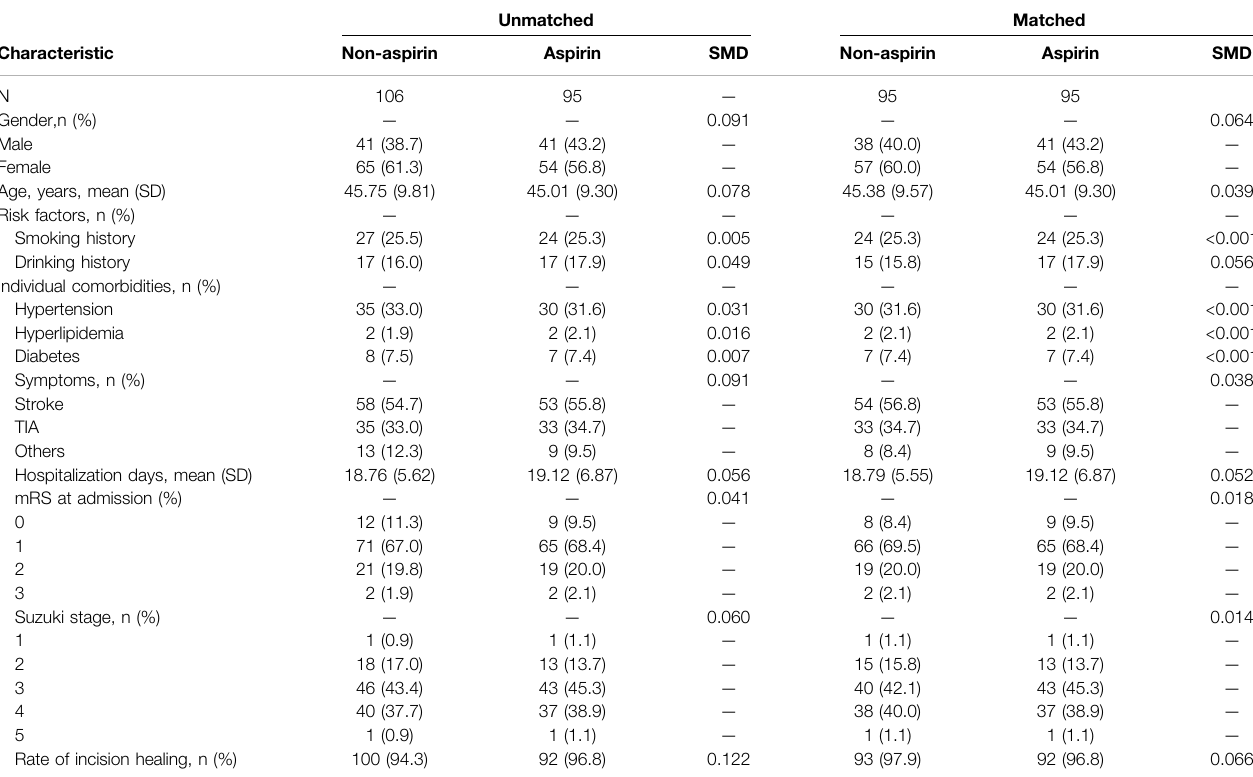
TABLE 1 | Baseline characteristics of patients in the aspirin and non-aspirin